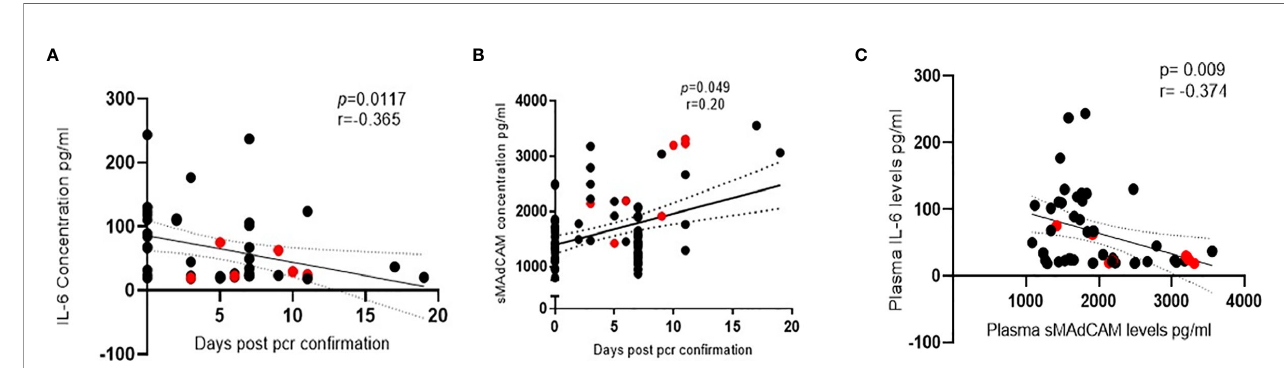
FIGURE 2 | Association of IL-6 and soluble MAdCAM inSARS-CoV-2 infection. (A, B) Association of (A) IL-6 levels(n = 47)and (B) soluble MAdCAM levels(n= 95) in plasma of SARS-CoV-2 infectedstudy participants with dayssince SARS-CoV-2 con fi rmation by PCR. (C) Association of IL-6 and soluble MAdCAM amongin-patients ’ (n = 47) r indicates strength of correlation; p indicates signi fi cance. Negative r value indicates inverse correlation.Redcolored symbols represent asymptomaticindividuals. Statistical signi fi cance was calculated by Spearman correlation analysis.